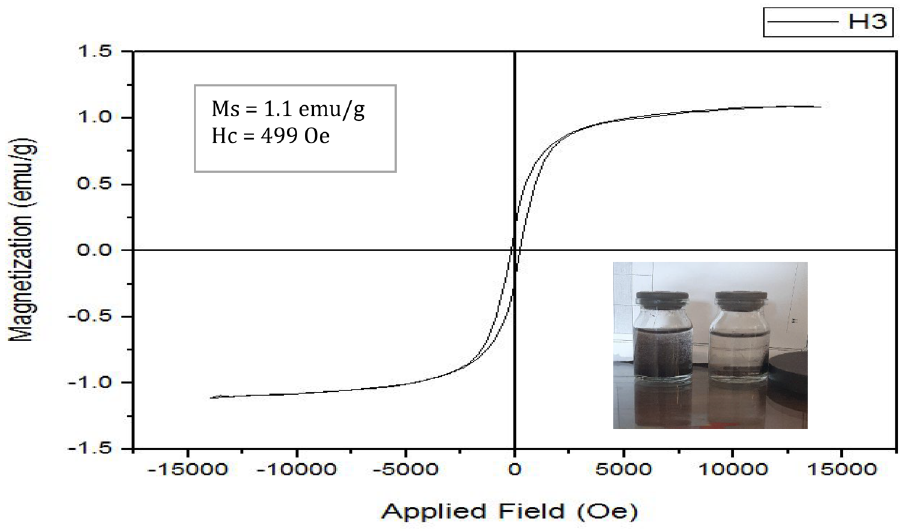
Figure 4. The magnetization curve (VSM) of the Ni 0.5 Co 0.5 Fe 2 O 4 @AC/Ch nanobiocomposite and its easy desorption from aqueous solutions by an external field.